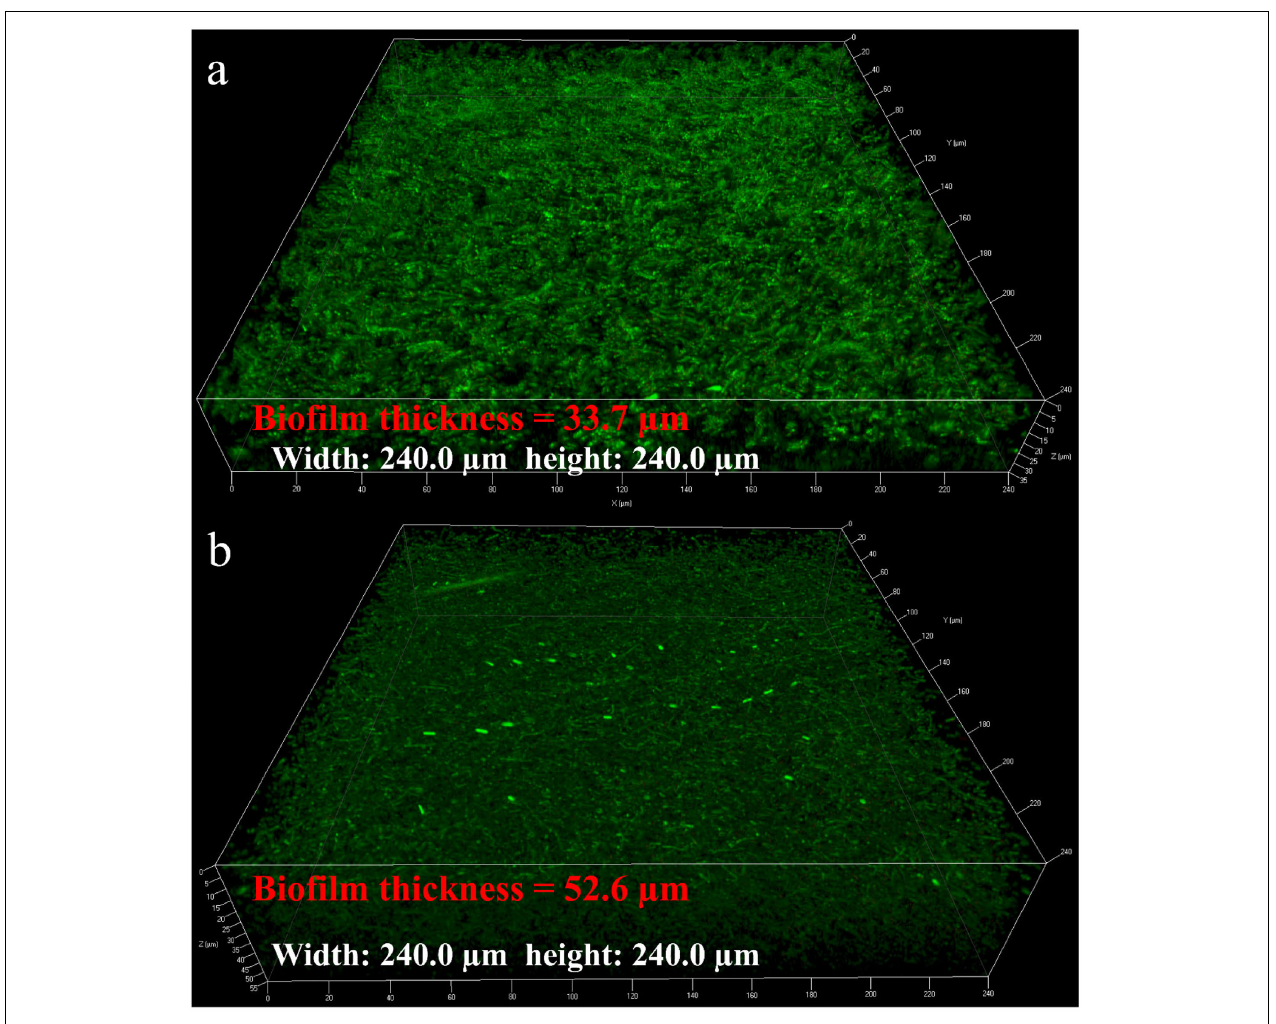
FIGURE 3 | Confocal laser scanning microscopy (CLSM) images of the coupon surface after incubation for 7 days (a) and 14 days (b)